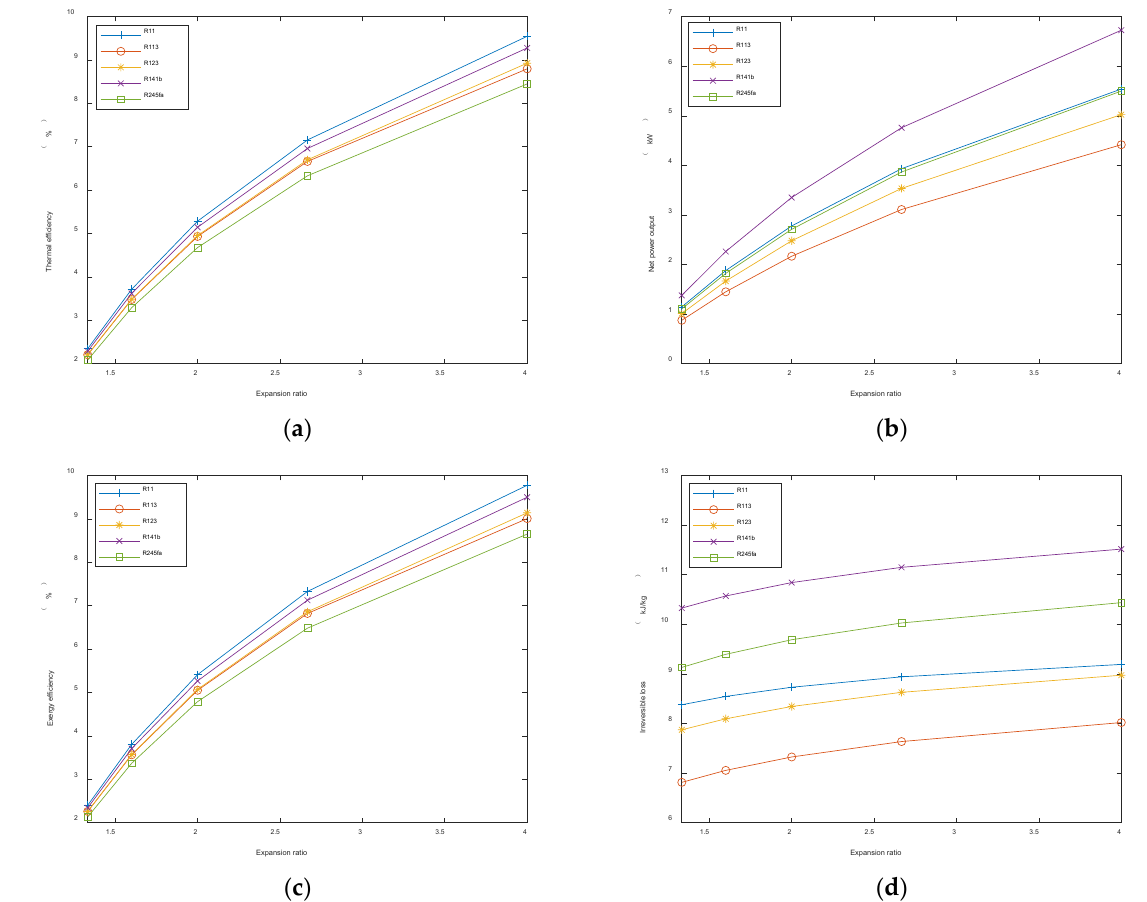
Figure 9. The influence diagram of different organic refrigerant expansion ratios on system performance. ( a ) The effect of expansion ratio of different organic working fluids on thermal efficiency; ( b ) The effect of different organic expansion ratio on the net output power; ( c ) Effect of expansion ratio of different organic working fluids on exergy efficiency; ( d ) The effect of different organic expansion ratios on irreversible loss.